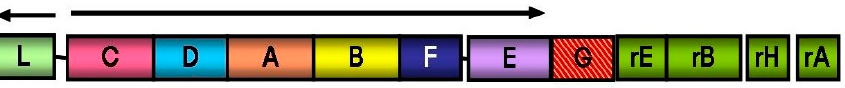
Figure 2. Gene organization of the lux operon region in bioluminescence bacteria of Photobacterium phosphoreum species. Arrows indicates the direction of transcription and “r” indicates riboflavin genes. The functions of genes are shown in Figure 1.